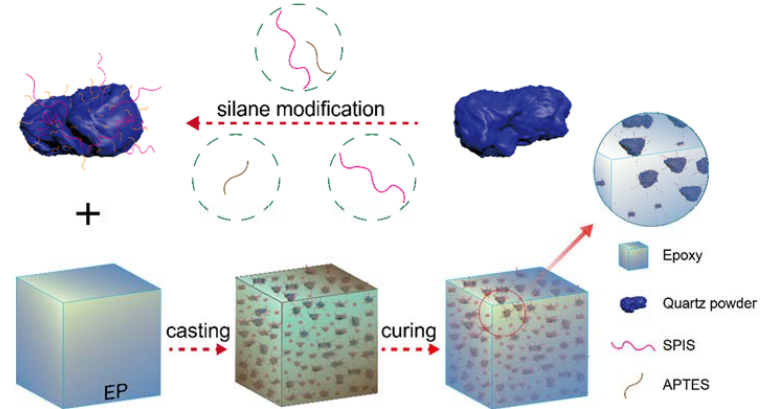
Figure 2. Illustration of the QP–EP composite